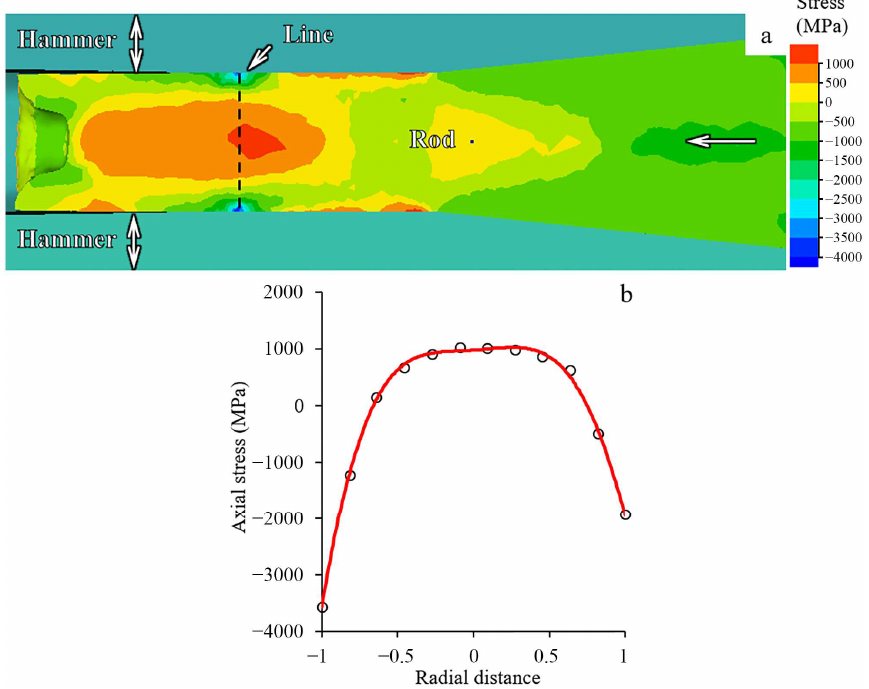
Figure 9. ( a ) Map of axial stress distribution and ( b ) axial stress-radial distance plot during swaging of the rod on the last step (a 95% reduction). Stress distribution in Figure 9b was estimated along the line in Figure 9a.